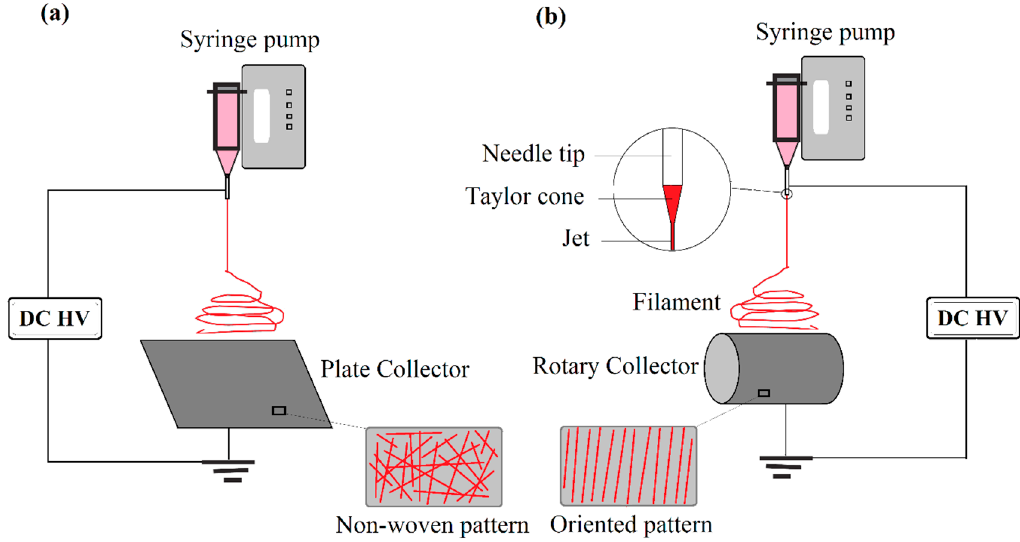
Figure 1. Schematic electrospinning methods.